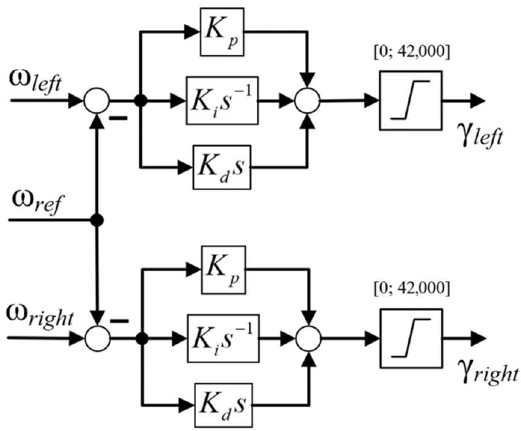
Figure 9. Structural diagram of the regulator with independent control of the left and right retarders. Based on the obtained functions, the synthesis of three types of controllers was per-